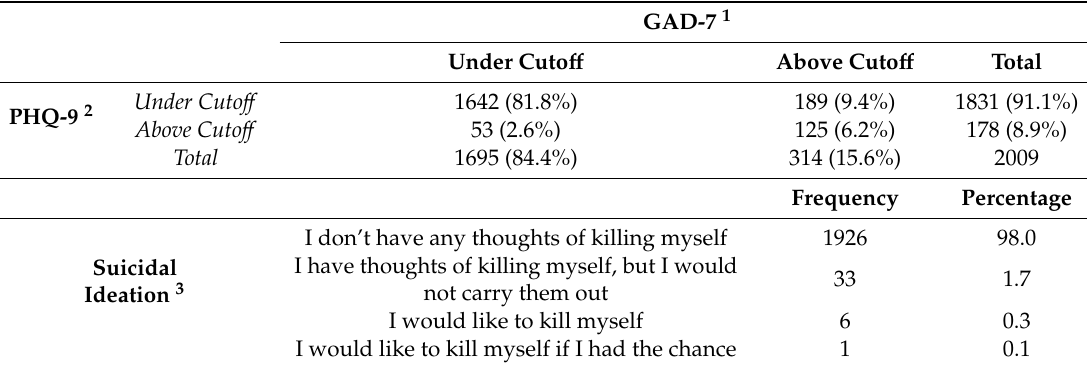
Table 2. Psychological characteristics of the sample.